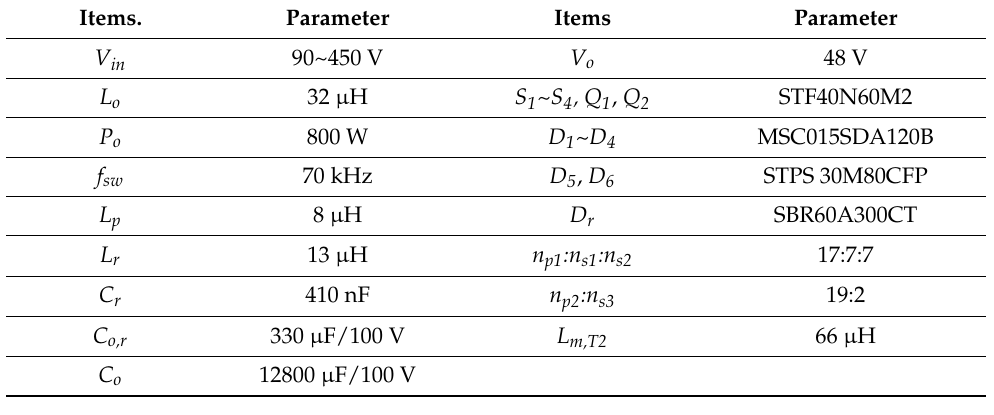
Table 1. Circuit parameters in the laboratory prototype. Items.